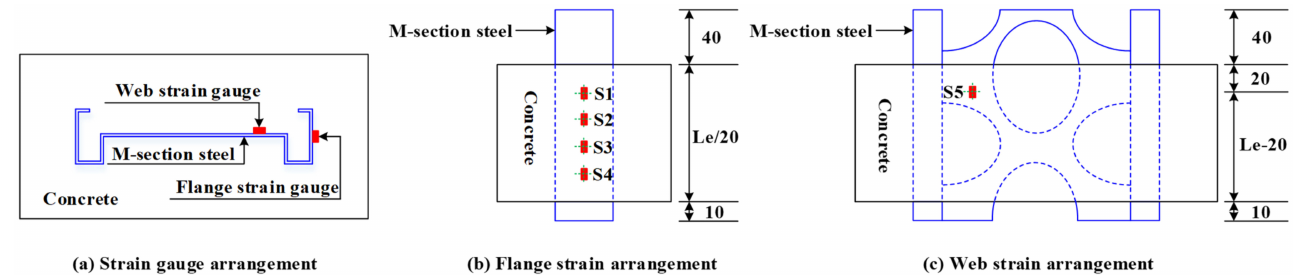
Figure 7. Layout of strain gauges (unit: